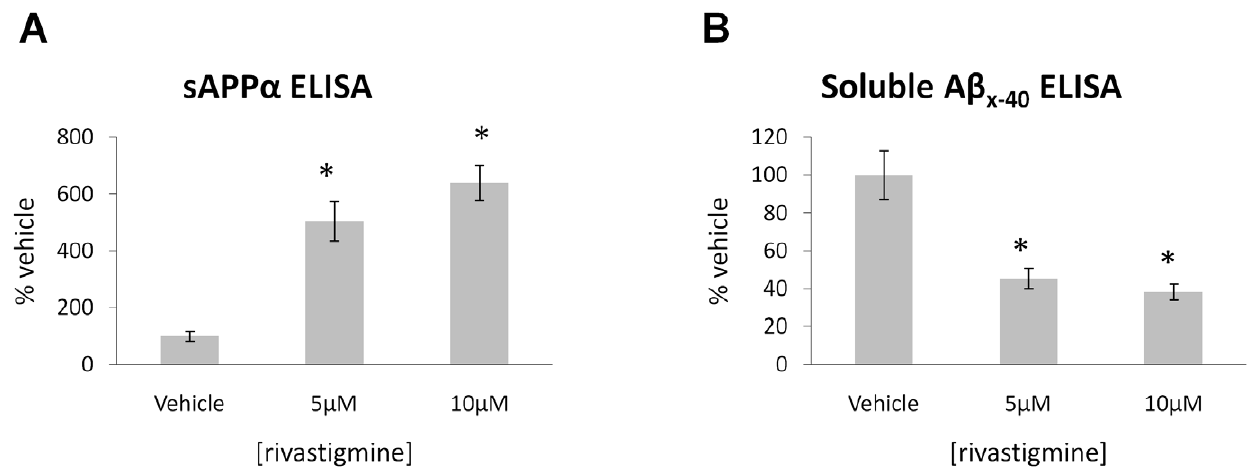
Figure 5. Rivastigmine shifts APP processing toward the a -secretase pathwayI. Levels of sAPP a and A b x-40 were measured in media samples of cultures treated with rivastigmine using ELISA techniques. A: sAPP a increased significantly in response to both 5 m M and 10 m M rivastigmine (both p , 0.01), but the treatments were not significantly different rom each other suggesting a maximum effect of rivastigmine at or below 5 m M. B: A b x-40 levels were decreased by both concentrations of rivastigmine (both p , 0.01). This effect was also not dose-dependent, suggesting a maximum effect at 5 m M or lower concentrations. Together, these data suggest a shift in the relative activities of the a - and b -secretase pathways, favoring production of the neurotrophic a -secretase product sAPP a while simultaneously reducing the neurotoxic b -secretase product A b .